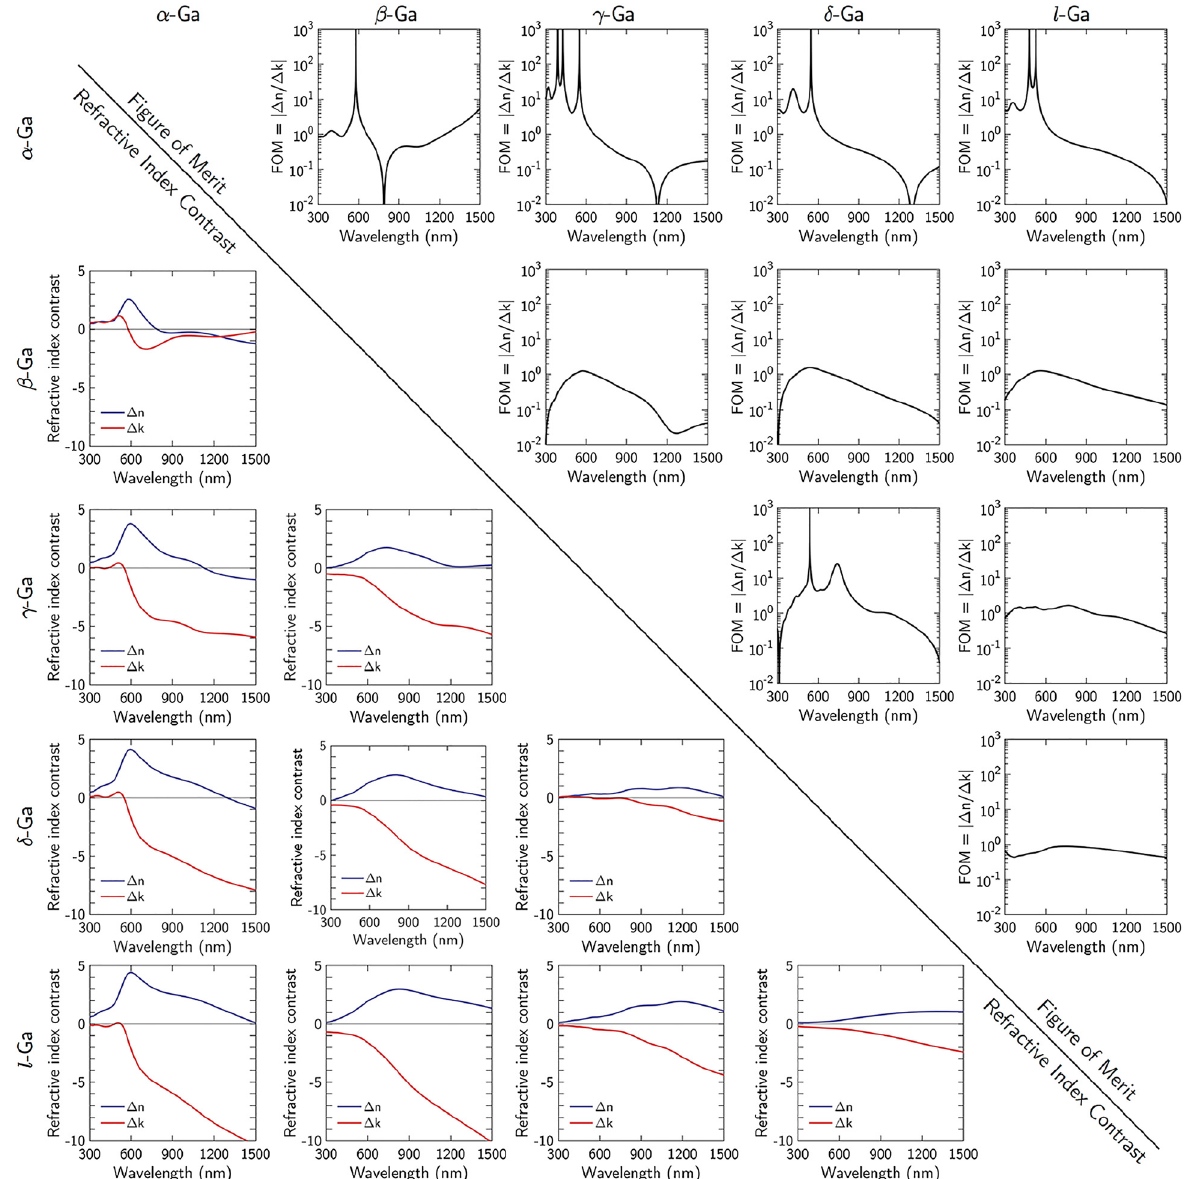
Figure5: Figure-of-merit(FOM)andrefractiveindexcontrastinGaphasetransformations.CombinationmatrixplotoftheFOM= Δ n / Δ k (upper diagonal matrix) and refractive index contrast Δ n and Δ k (down diagonal matrix) on phase transition between Ga phase